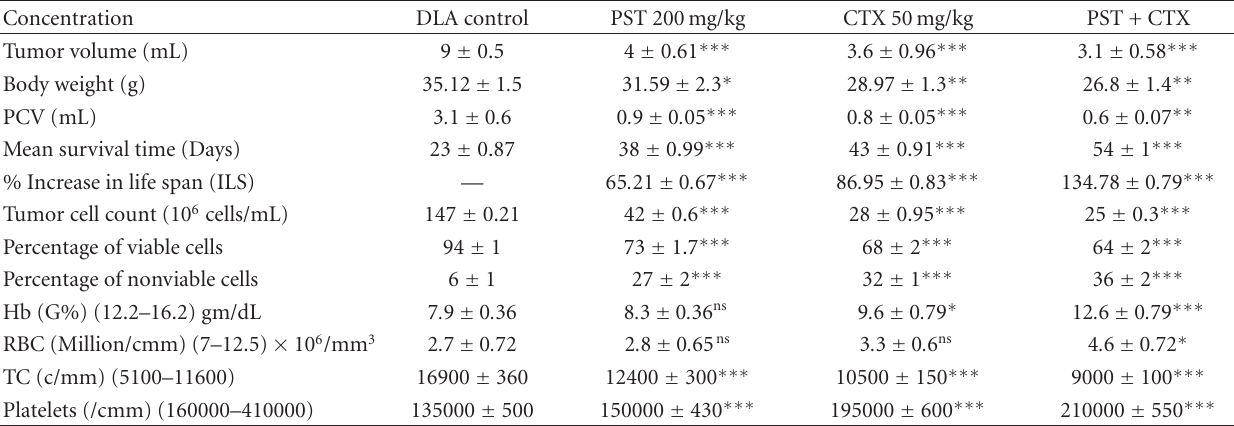
Table 3: Tumor and hematological characteristics in mice injected with drug for 7 days, DLA administered on 8th day, observed for 21 days, and dissected on 22nd day (Group